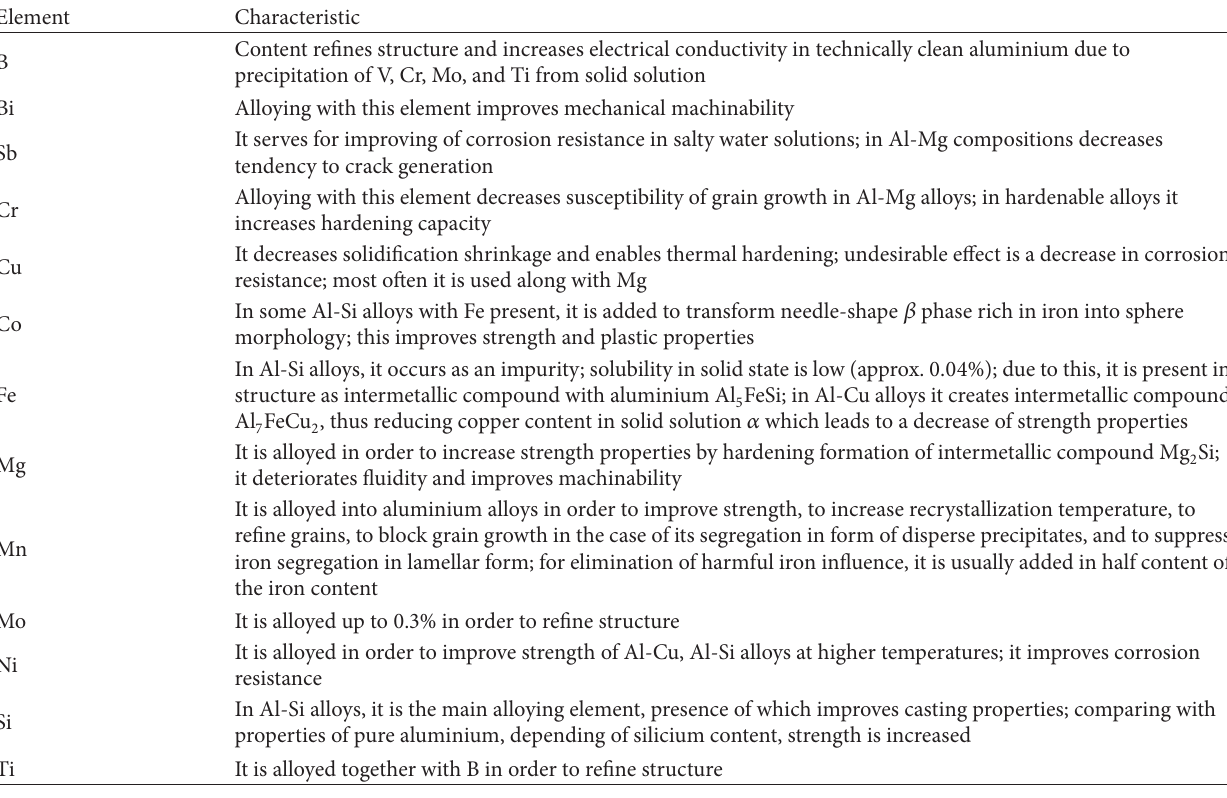
Table 1: Characteristic, properties, and impact of chosen alloying elements [11, 12, 14–20].